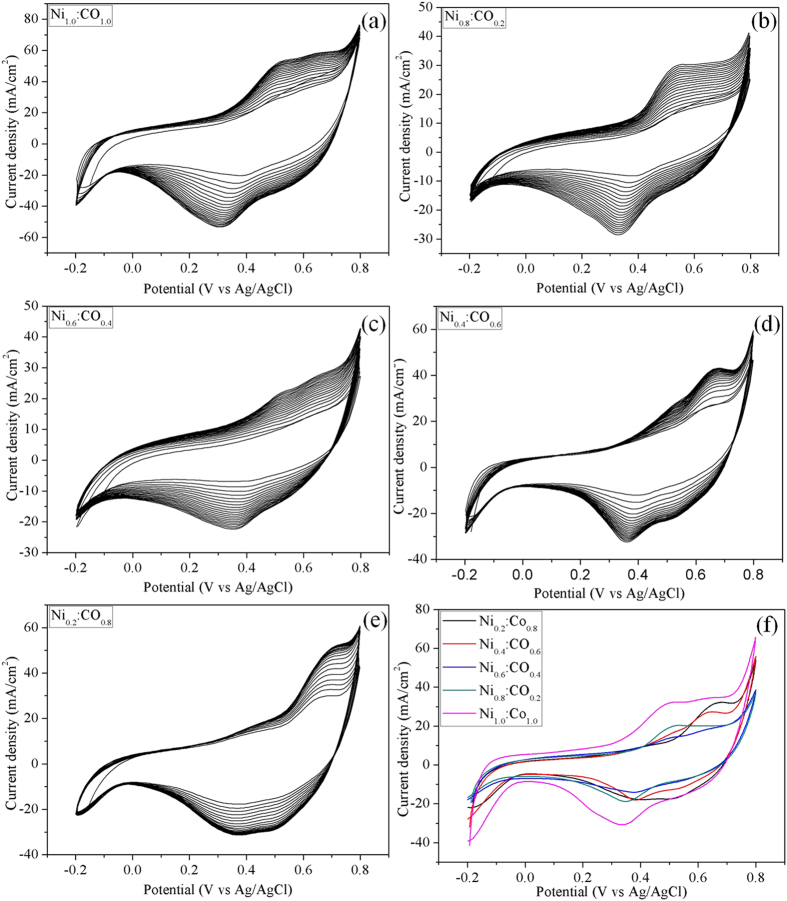
Cyclic voltammograms (first 20 cycles, (a–e) in presence of 1.0 M KOH at 100 mV/s for NiCo2O4/MWCNT with different Ni:Co ratios (Ni:Co = 0.2 : 0.8, 0.4 : 0.6, 0.6 : 0.4, 0.2 : 0.8, 1.0 : 1.0). (f) shows the cyclic voltammograms after 20 cycles at 50  mV/s.